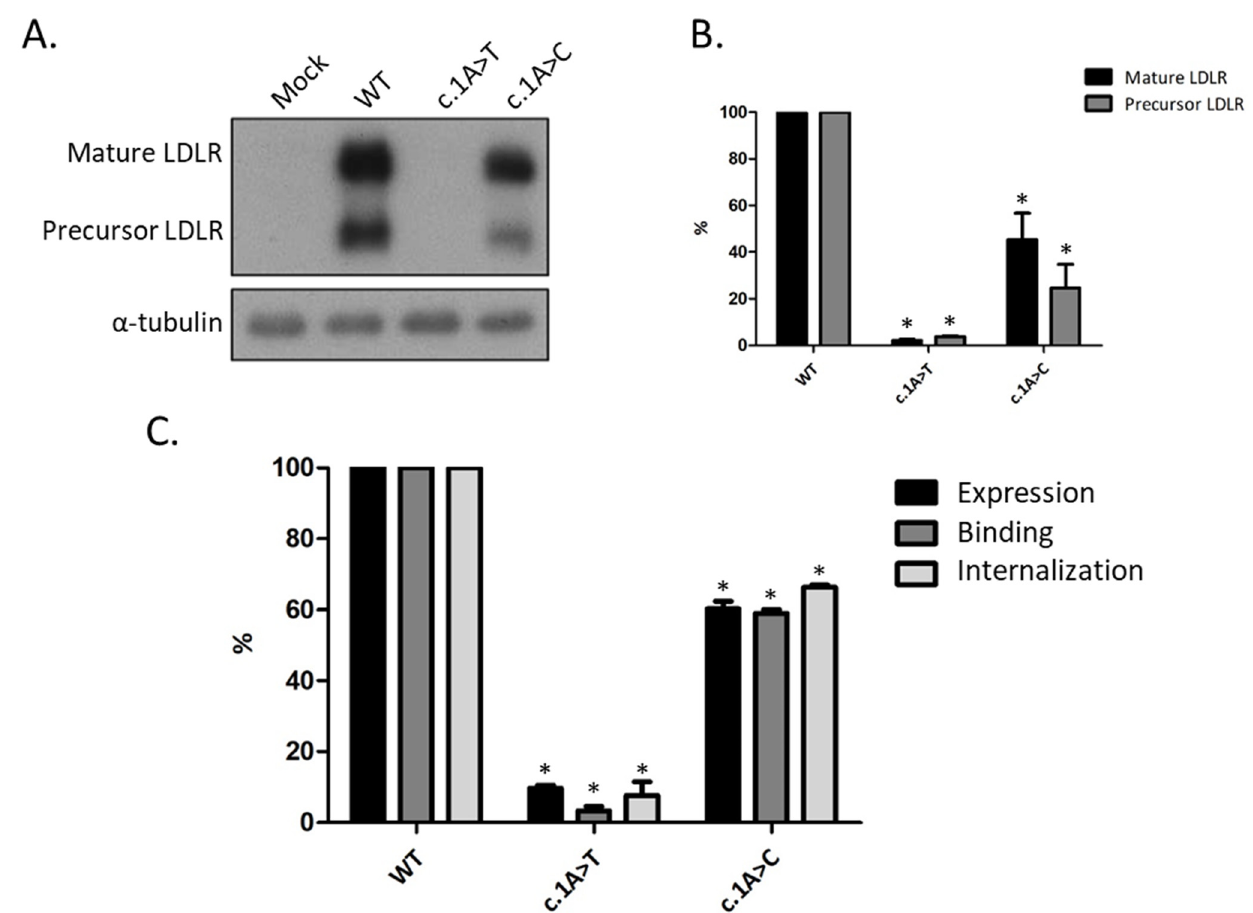
Figure 1. Expression and activity of LDLR in CHO-ldlA7 cells transfected with wild-type (WT), c.1A>T, p.(Met1Leu), or c.1A>C, p.(Met1Leu) variants. After 24 h of overexpression, cells were lysed, and protein extracts were analyzed ( A ) by Western blot, as previously described in Methods. ( B ) The relative band intensities of both mature (black bars) and precursor (grey bars) LDLR forms were calculated, respectively, as the ratio of 160 kDa or 120 kDa LDLR band intensity to that of α -tubulin. ( C ) Black bars— LDLR expression; Dark grey bars—LDL(FITC)- LDLR binding after 3 h incubation at 4 ◦ C; Light grey bars—LDL(FITC) internalization after 3 h incubation at 37 ◦ C. Geometric fluorescence intensity of 15,000 events was acquired in a Facscalibur Flow cytometer, as mentioned above. All values represent the mean of triplicate independent determinations ( n = 3); error bars represent ± SD. * p < 0.001 compared to LDLR WT using a two-tailed Student’s t